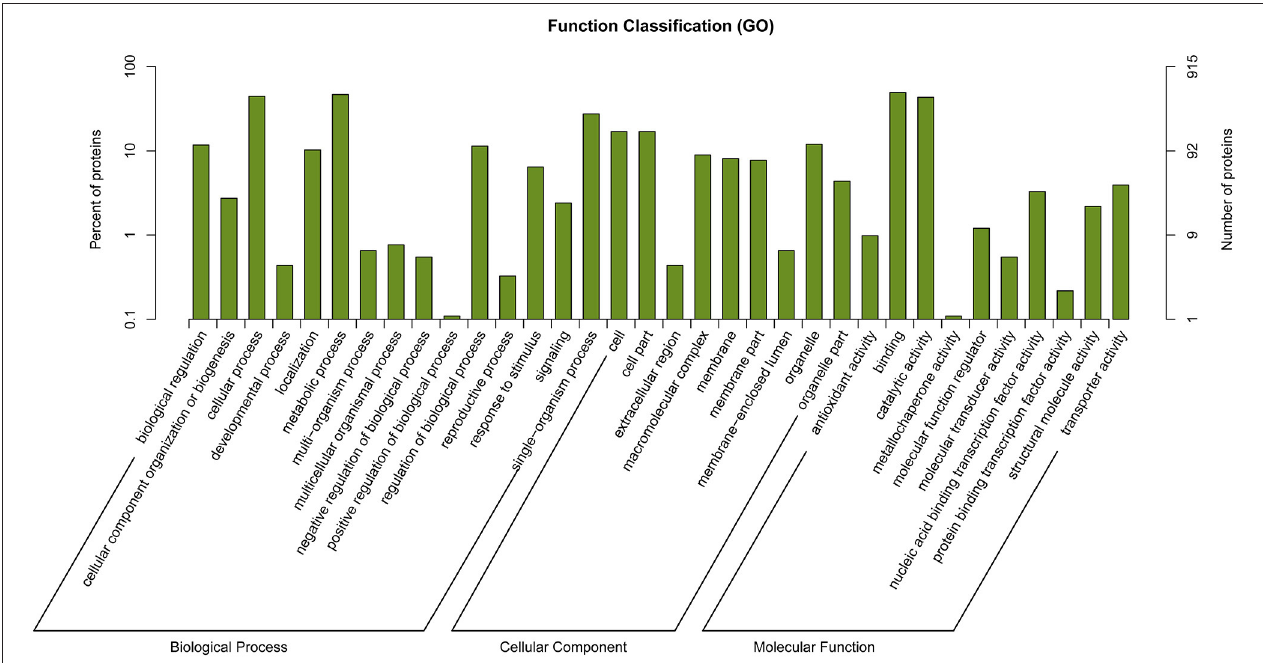
FIGURE 6 | GO enrichment analysis in highly differentiated regions between P. davidiana and P. alba